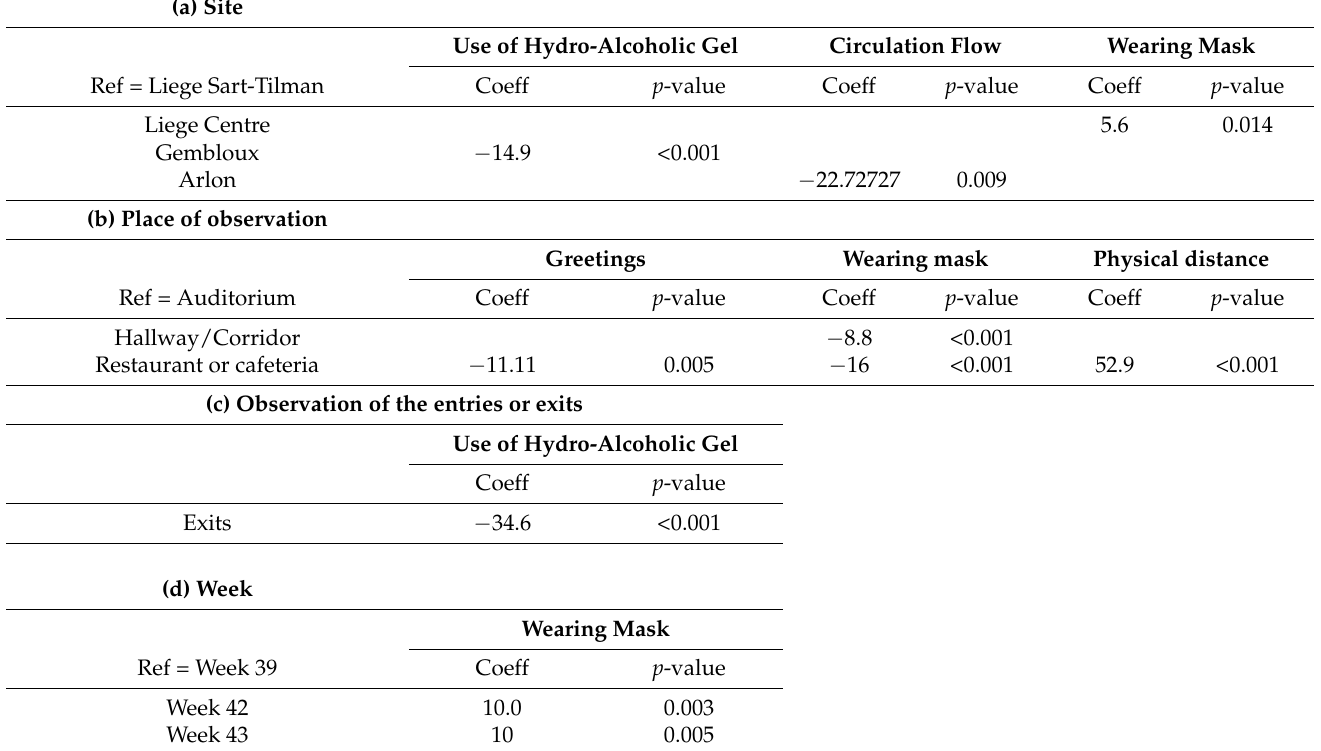
Table 4. Results of the univariate quantile regression models with significant differences based on: (a) sites, (b) place of observation, (c) observation of the entries or exits, (d) week, (e)